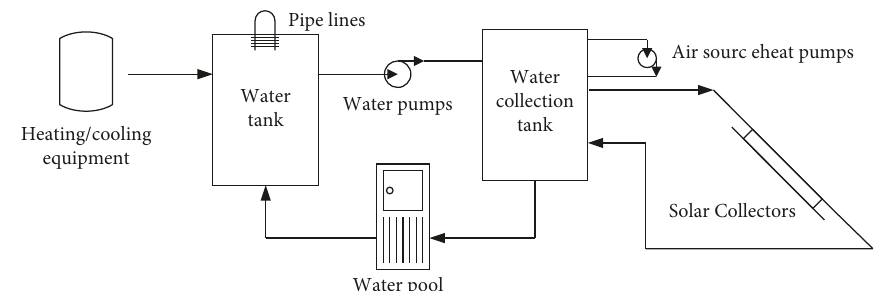
Figure 2: Schematic diagram of ASHP-assisted